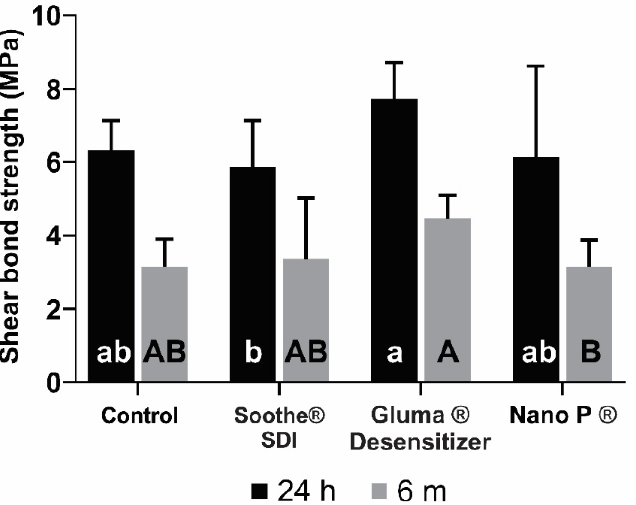
Figure 2. Shear bond strength for study groups (surface treatment and aging times). The same lowercase letters indicate no difference between desensitizers at 24 h. The same uppercase letters indicate no difference between desensitizers at 6 months.